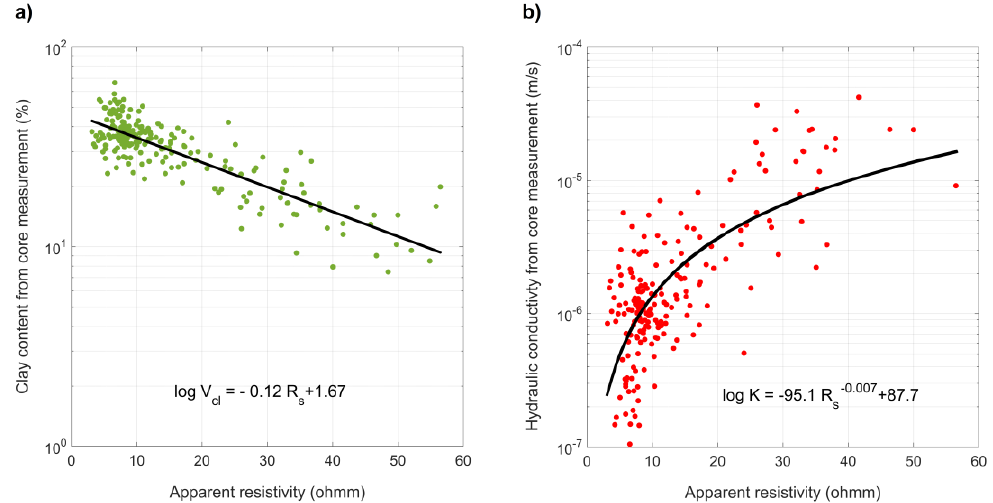
Figure 12. Regression relationships between the measured (apparent) resistivity and petrophysical parameters of the studied groundwater formations: ( a ) resistivity vs. clay content; ( b ) resistivity vs. hydraulic conductivity in Baktalórántháza-1 well.